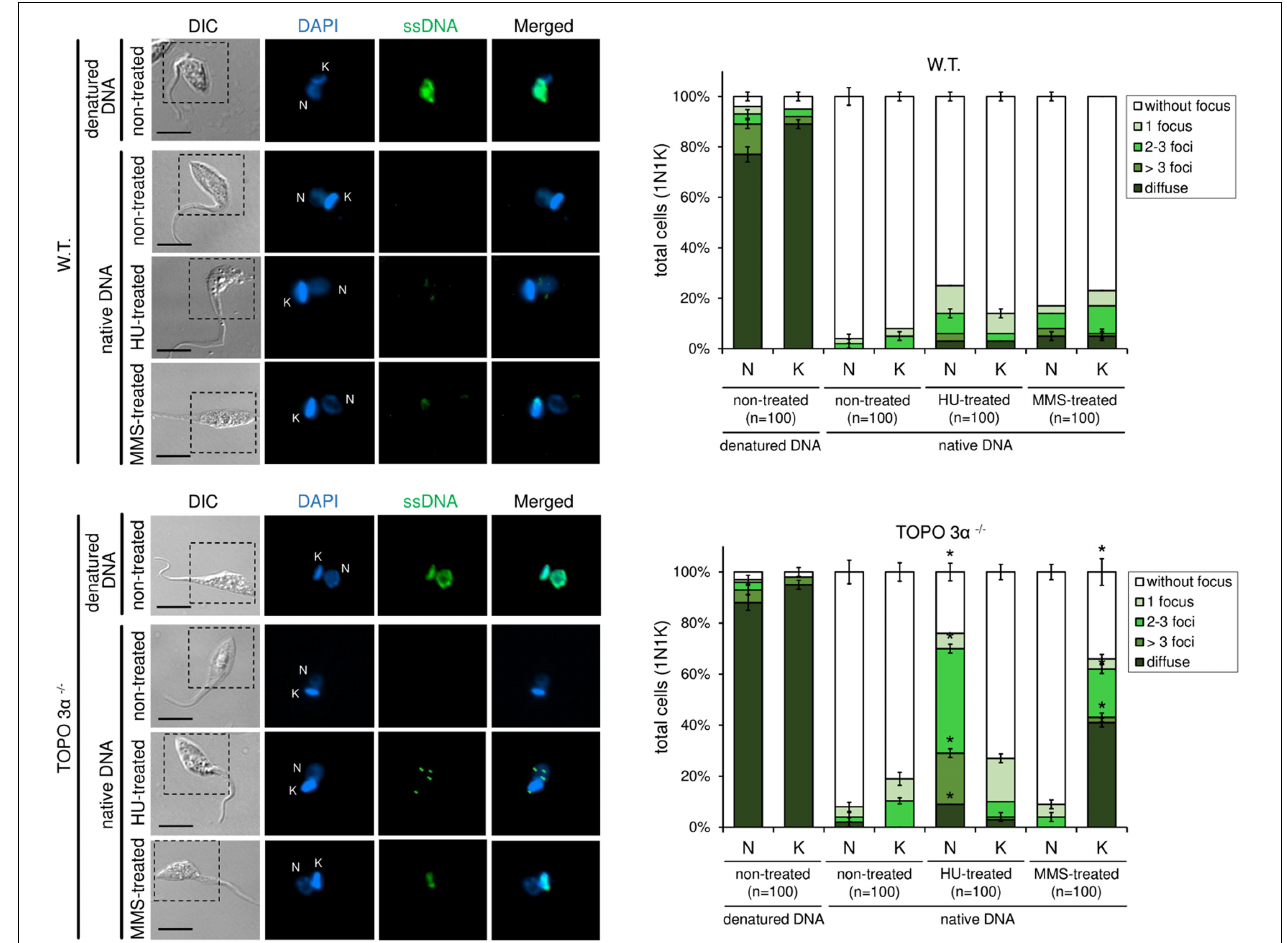
FIGURE 8 | 5-bromo-2 (cid:48) -deoxyuridine (BrdU) native detection assay reveals that TcTopo3 α KO parasites are more sensitive to genotoxic stress caused by HU or MMS. WT parasites naturally show very low levels of single-stranded DNA (ssDNA) foci either in the nucleus (N) or kinetoplast (k). After HU treatment, the number of ssDNA foci (green) per cell, especially in the nucleus, increases significantly in TcTopo3 α KO parasites relative to WT. However, after MMS treatment, the pattern and the number of ssDNA foci per cell increased in kinetoplast but not in the nucleus, showing a diffuse pattern in some cells and a dotted pattern in others. The bar graphs show the measurement of ssDNA foci distribution pattern according to each organelle (N and k) per cell. As a positive control, each lineage was treated with HCl to denature DNA and consequently expose the ssDNA. Black bars = 10 µ m. Error bars indicate SD. The differences observed were statistically significant relative to control using the Student’s t -test (* p < 0.05); n = 100 for each condition